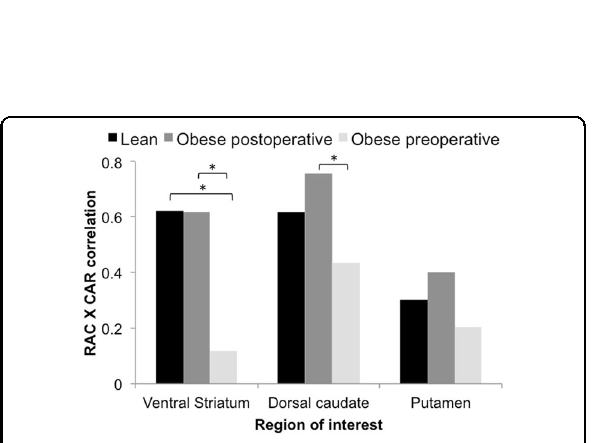
Fig. 2 Mean correlations between [ 11 C]raclopride BP ND and [ 11 C] carfentanil BP ND in non-obese and obese subjects before and after surgery. Asterisks denote signi fi cant between-groups